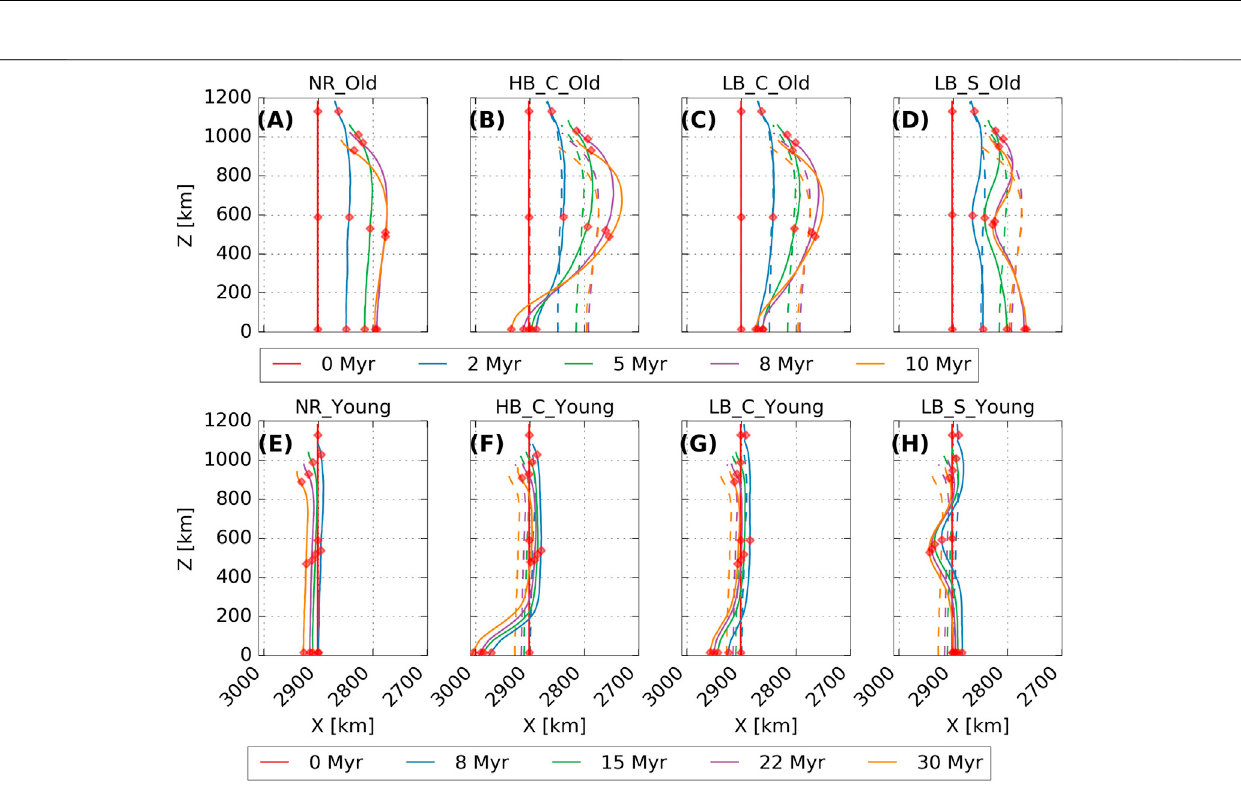
Frontiers in Earth Science |